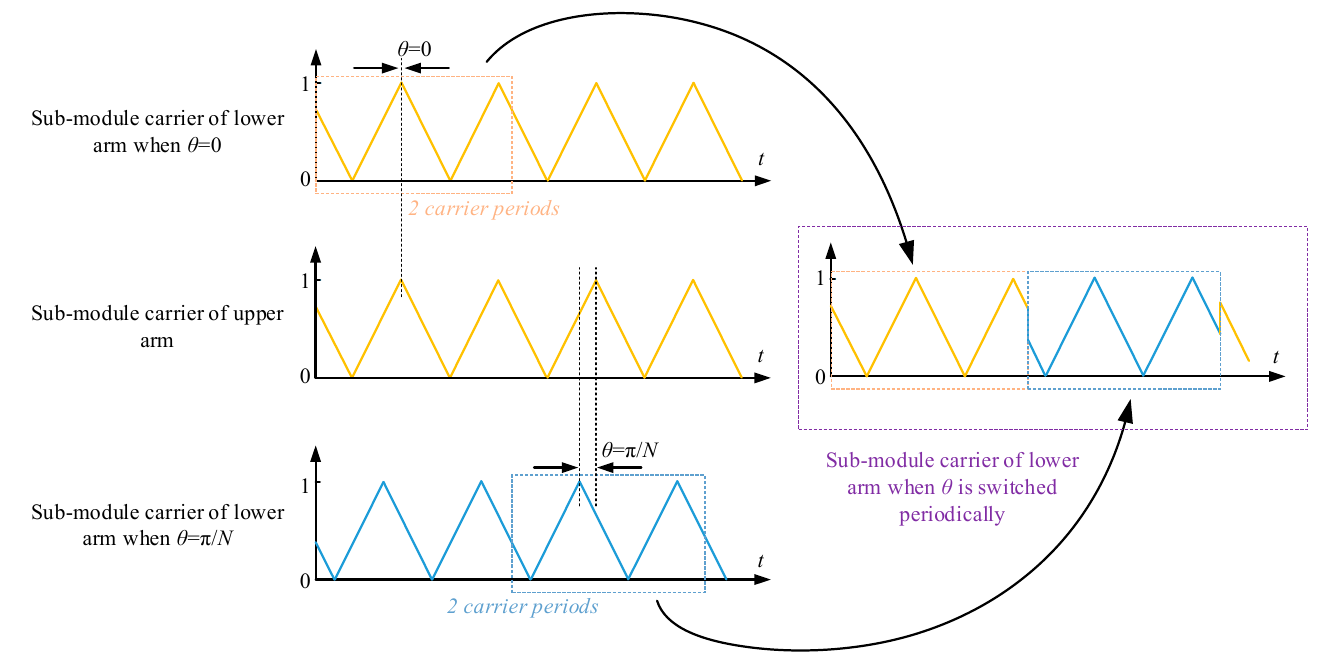
Figure 3. CPS-PWM schematic diagram when SDA-based CPS modulation is adopted. Based on the conclusion in Section 2, at this time, the even harmonic group amplitudes of the output voltage and the circulating current are at the maximum and minimum values, respectively, whereas their odd harmonic group amplitudes will be compromised between the maximum and minimum values: